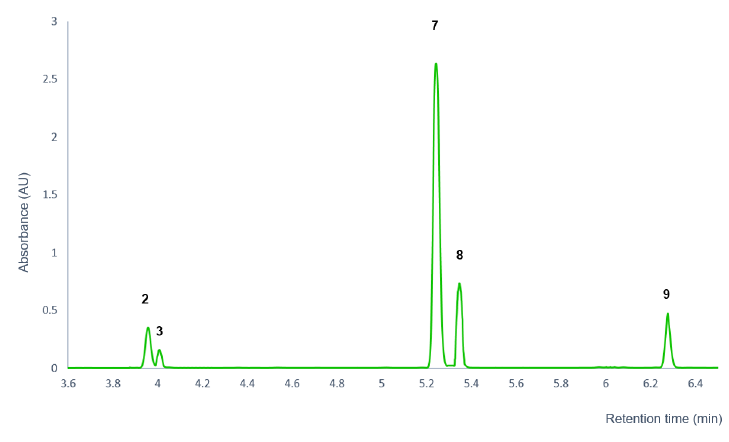
Figure 8. UPLC-DAD chromatogram of the decomposition products of 1′ S -1′-acetoxychavicol ace- tate ( 9 ).